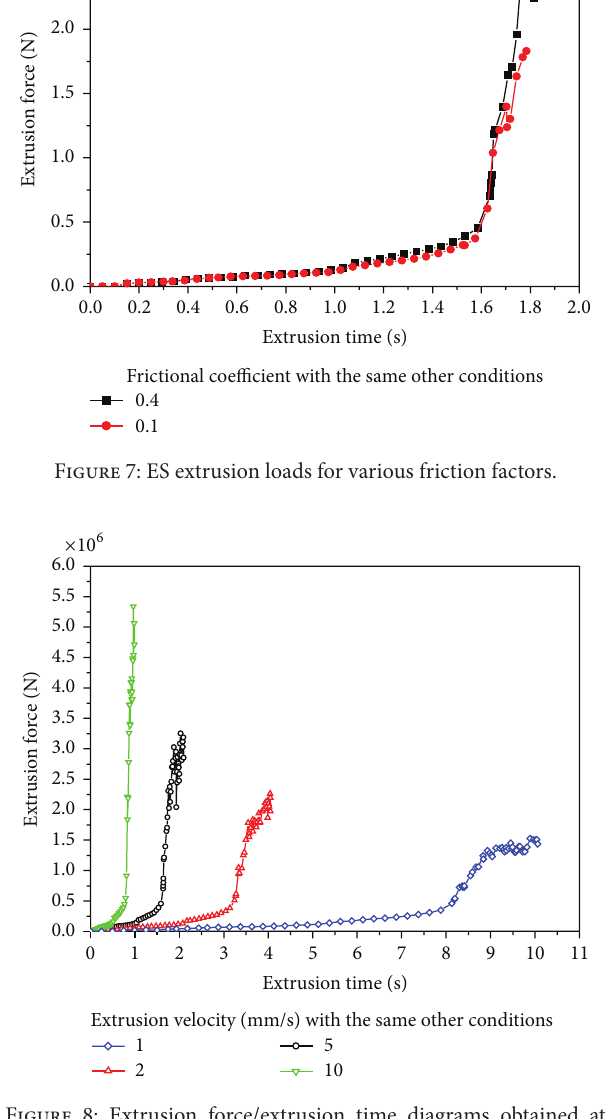
Figure 8: Extrusion force/extrusion time diagrams obtained at various extrusion speeds.